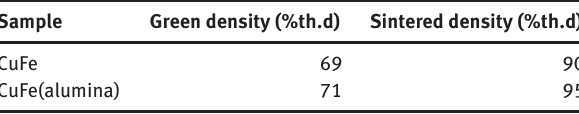
Table 2: Density of CuFe alloy and CuFe(alumina) nanocomposite. Sample Green density (%th.d) Sintered density (%th.d) CuFe 69 90 CuFe(alumina) 71 95 (%th.d), percentage of the theoretical